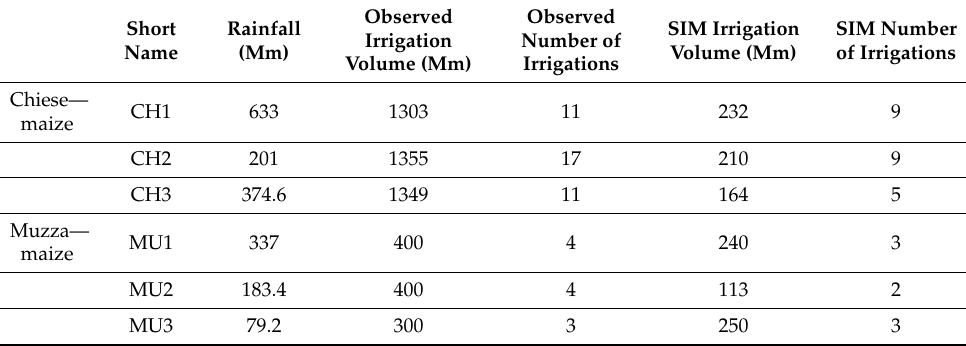
Table 7. SIM strategy application in the Chiese and Muzza Irrigation